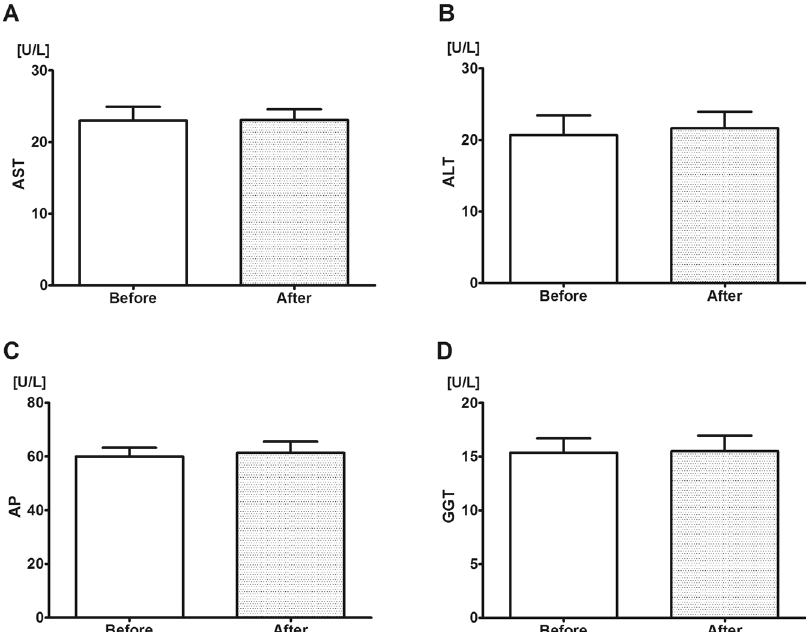
Figure 2. Liver-specific enzyme levels before and after alcohol consumption in humans. Enzyme levels were determined in plasma from blood samples taken on days 1 (control, left boxes) and 5 (last day of alcohol consumption, right boxes) of the investigation. During the first measurement, all volunteers were untreated. (A) Aspartate aminotransferase (AST), (B) Alanine aminotransferase (ALT), (C) Alkaline phosphatase (AP) and (D) Gamma glutamyl transferase (GGT) levels. Alcohol consumption did not alter enzyme levels. Mean values and standard error of mean (SEM) are given; p < 0.05 vs . day 1 (control). Statistics: Paired-test.